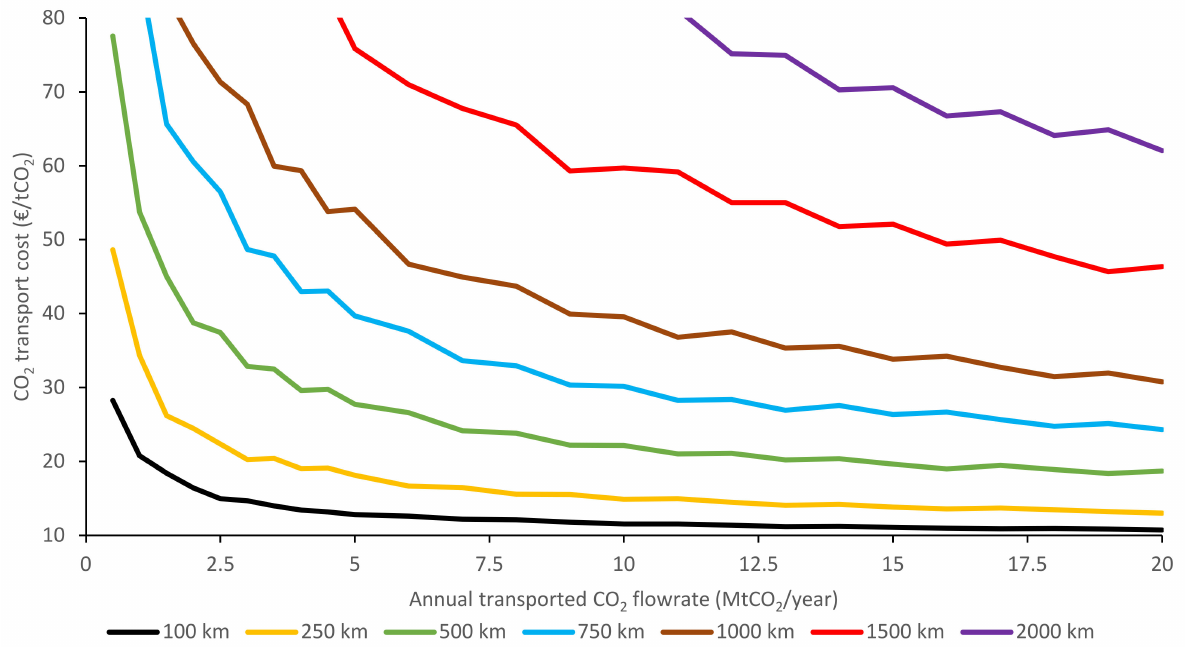
Figure A7. CO 2 conditioning and transport costs as a function of transport distance and annual volume when transporting pure CO 2 to an offshore site using an offshore